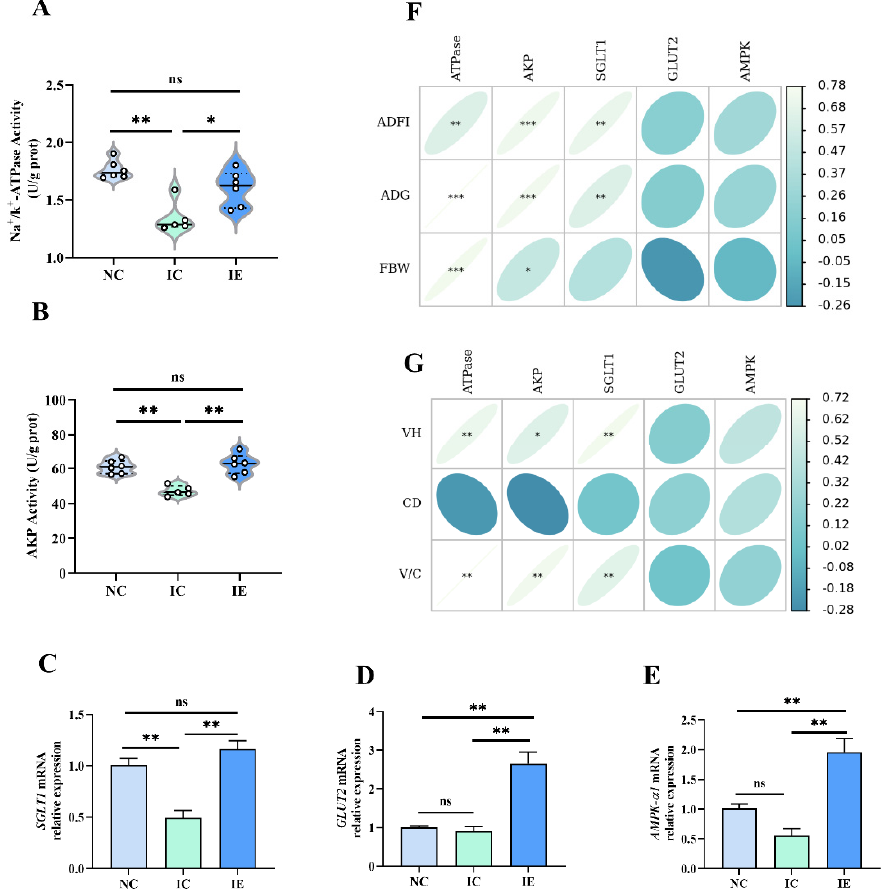
Figure 2. Effects of EGF on the intestinal glucose absorption capacity of piglets with IUGR. ( A ) Na + /K + -ATPase activity, ( B ) AKP activity, ( C ) SGLT1 mRNA, ( D ) GLU2 mRNA, ( E ) AMPK- α 1 mRNA, ( F ) correlations analysis between intestinal glucose absorption capacity and growth performance, ( G ) correlations analysis between intestinal glucose absorption capacity and intestinal morphology. Values are expressed as means ± SEM, n = 6 (1 pig in the IC group was dead, n = 5 in the IC group); NC: NBW piglets fed with basal diet; IC: IUGR piglets fed with basal diet; IE: IUGR piglets fed with basal diet supplemented with 2 mg/kg EGF. * p < 0.05, ** p < 0.01, *** p <